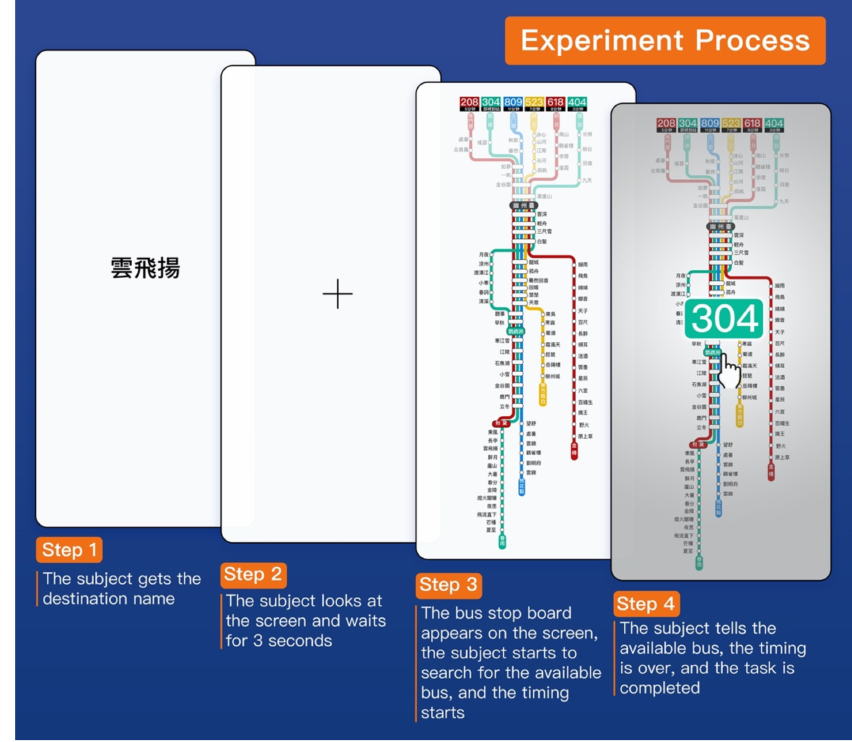
Figure 4. Experiment process